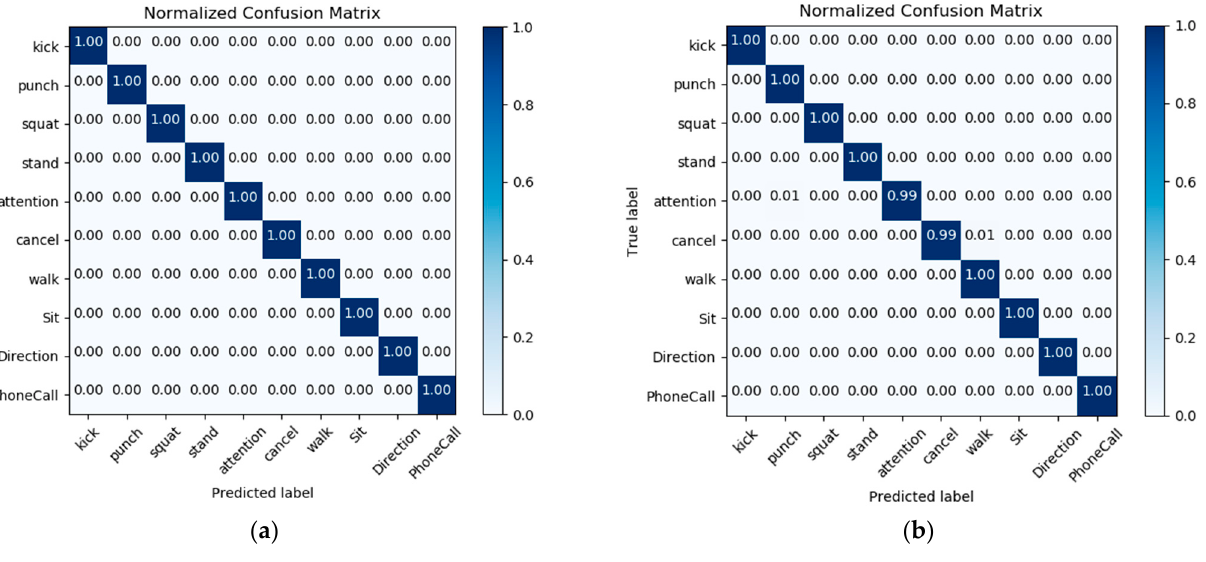
Figure 10. Standard matrix with predicted labels on X -axis and true labels on the Y -axis tested on body gesture training set ( a ) and in testing dataset ( b ).